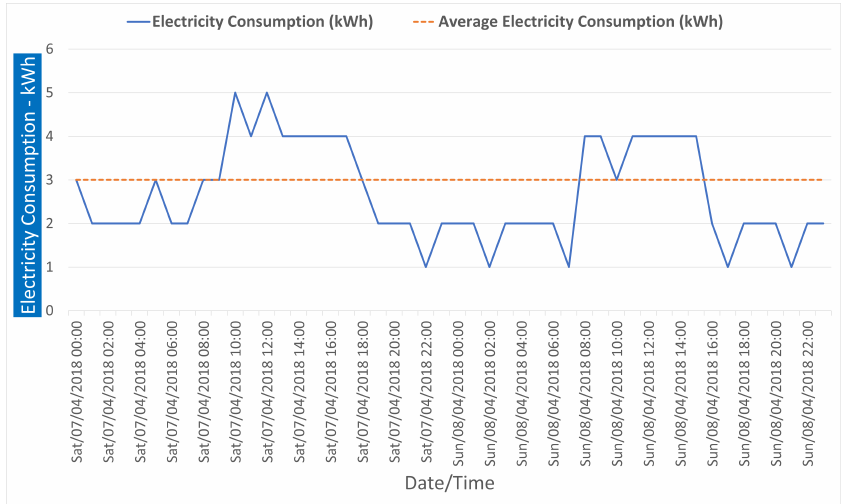
Figure 4. Hourly electricity consumption in the weekend 7 April 2018 to 8 April 2018 of week 19